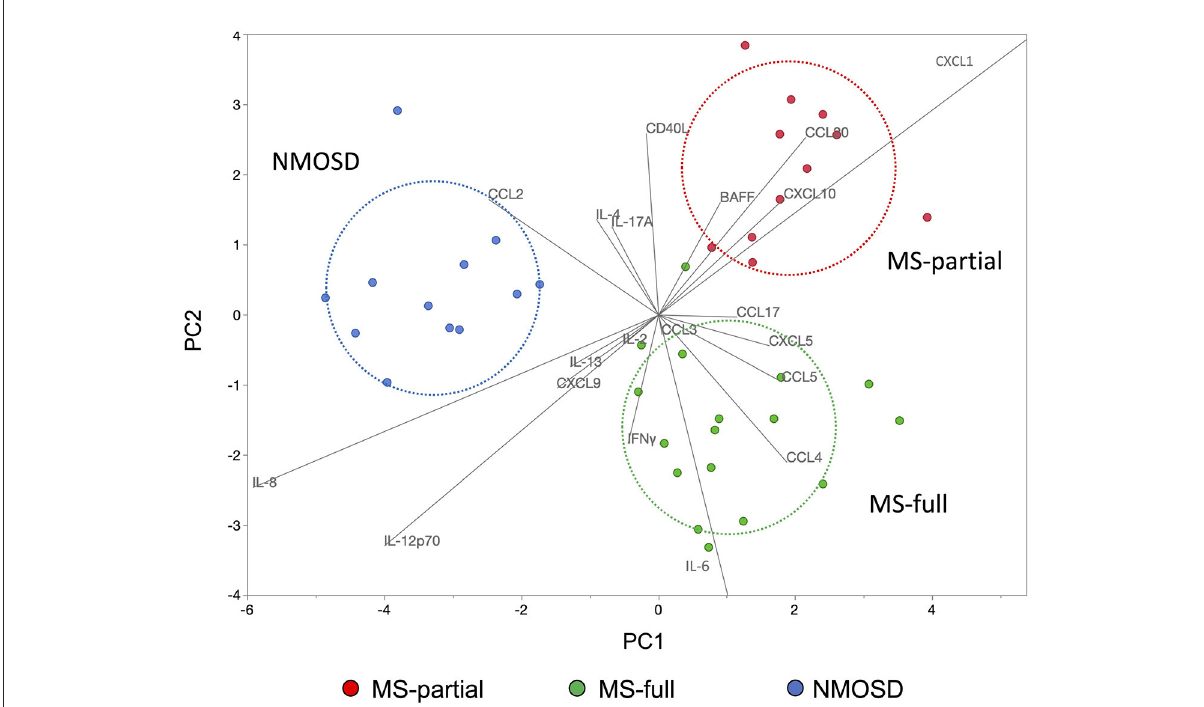
FIGURE4 Discriminant analysis using cytokine and chemokine levels in CSF. The use of discriminant analysis to confirm that the characteristics of cytokine and chemokine levels in the CSF could be used to distinguish three groups: MS-full (green dots), MS-partial (red dots), and NMOSD (blue dots) groups. Explanatory variables were decided by the stepwise selection method. Each circle indicates the determined group area with 50% probability. CSF, cerebrospinal fluid; MS, multiple sclerosis; NMOSD, neuromyelitis optica spectrum